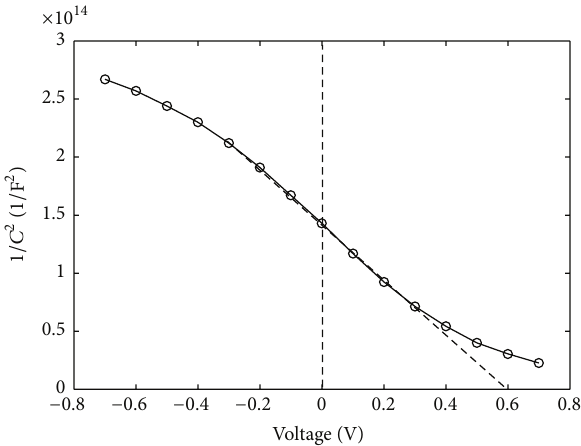
Figure 8: The capacitance-voltage characterization of LCPV mod-